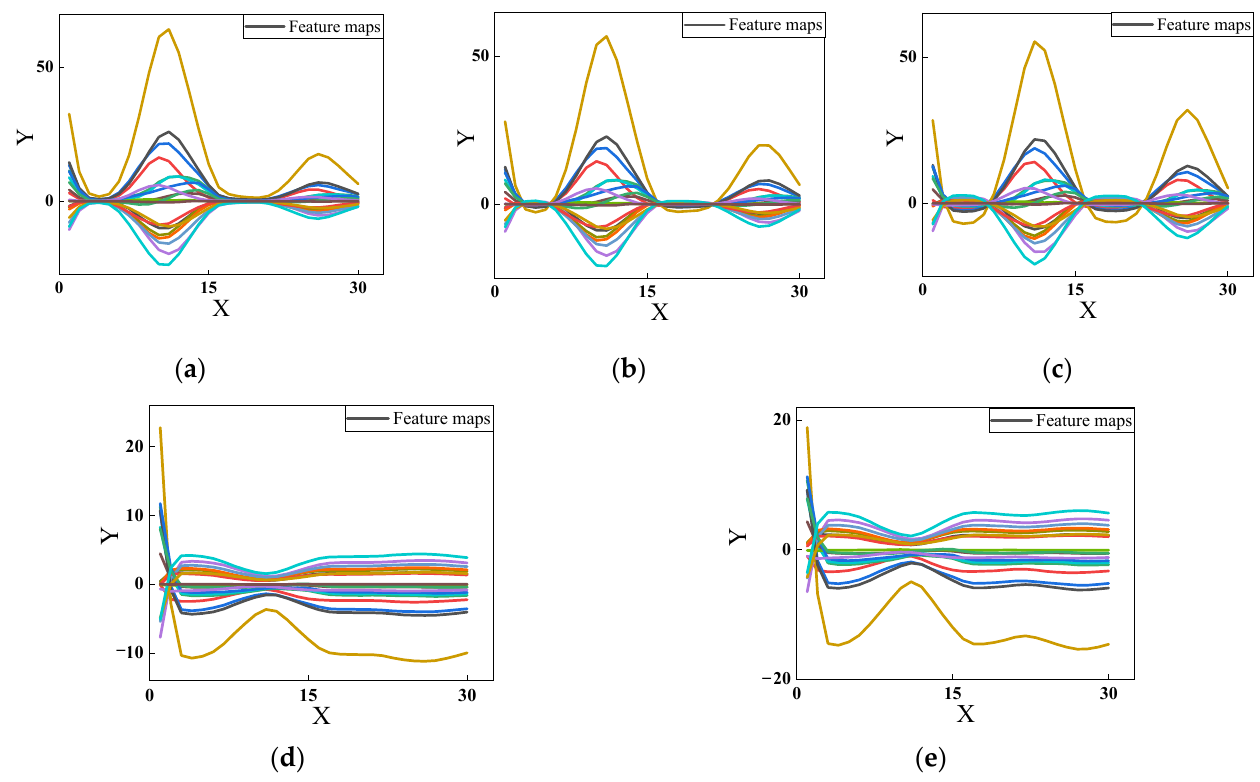
Figure 9. Feature maps: ( a ) 0% UTS; ( b ) 20% UTS; ( c ) 40% UTS; ( d ) 60% UTS; ( e ) 80% UTS.